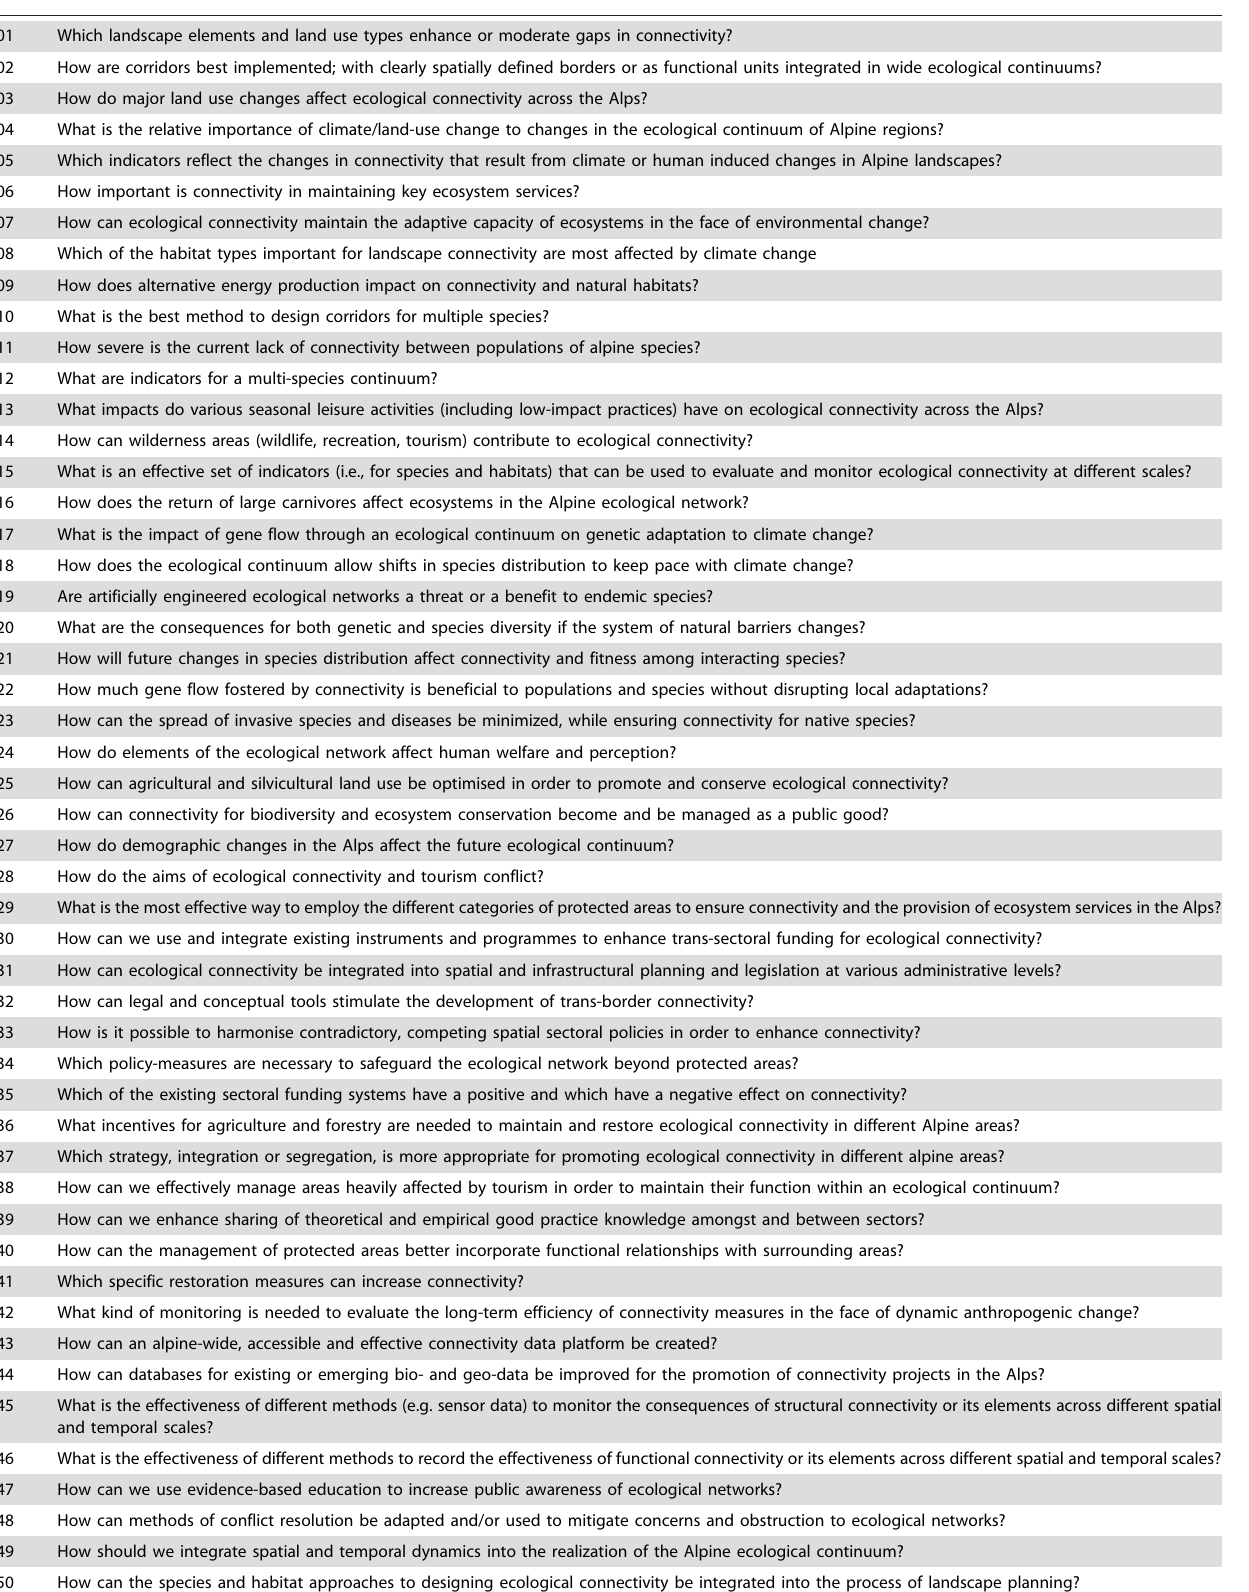
Table 1. Non-prioritized list of the 50 most important questions.